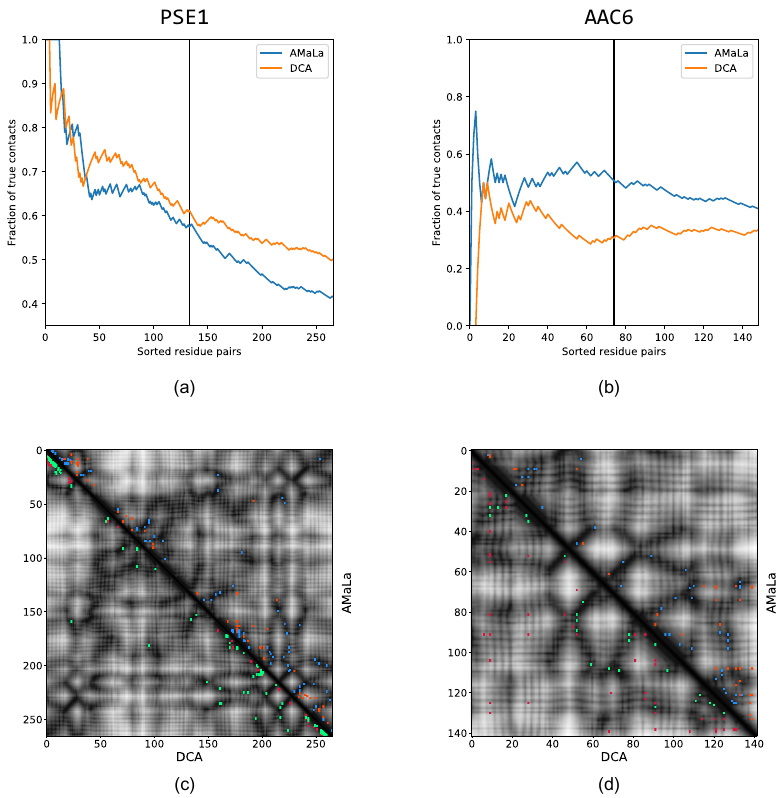
Figure 3. Top: sensitivity plot for contact prediction via parameters inferred on PSE-1 and AAC6 [29] datasets. Blue curve: the score is computed as the Frobenius norm of the couplings inferred with the AMaLa method. Orange curve: the score is computed as the Frobenius norm of the couplings inferred with the standard pseudo-likelihood maximization approach. In panel ( a ), we have the result for PSE-1. At the L /2-th ranked residue pair, AMaLa provides AUC ( L /2 ) = 0.71, PPV ( L /2 ) = 0.58, whereas PlmDCA yields AUC ( L /2 ) = 0.72, PPV ( L /2 ) = 0.61. Panel ( b ) shows the sensitivity plot for AAC6. In this case, AMaLa yields at half of the length AUC ( L /2 ) = 0.51, PPV ( L /2 ) = 0.51, whereas for PlmDCA, we have AUC ( L /2 ) = 0.34, PPV ( L /2 ) = 0.31. Bottom: contact maps up to L /2 predictions. In the upper-right half, the results related to AMaLa are reported, whereas in the lower-left, the prediction provided by PlmDCA is reported. Correctly predicted contacts are colored in green/blue, while wrong prediction are reported in red/orange for PlmDCA/AMaLa, respectively. Panel ( c ) reports the result for PSE-1. Even if DCA provides both higher AUC and PPV, AMaLa seems to predict more long range contacts. A similar outcome, although less pronounced, can be appreciated in panel ( d ), which shows the contact map related to